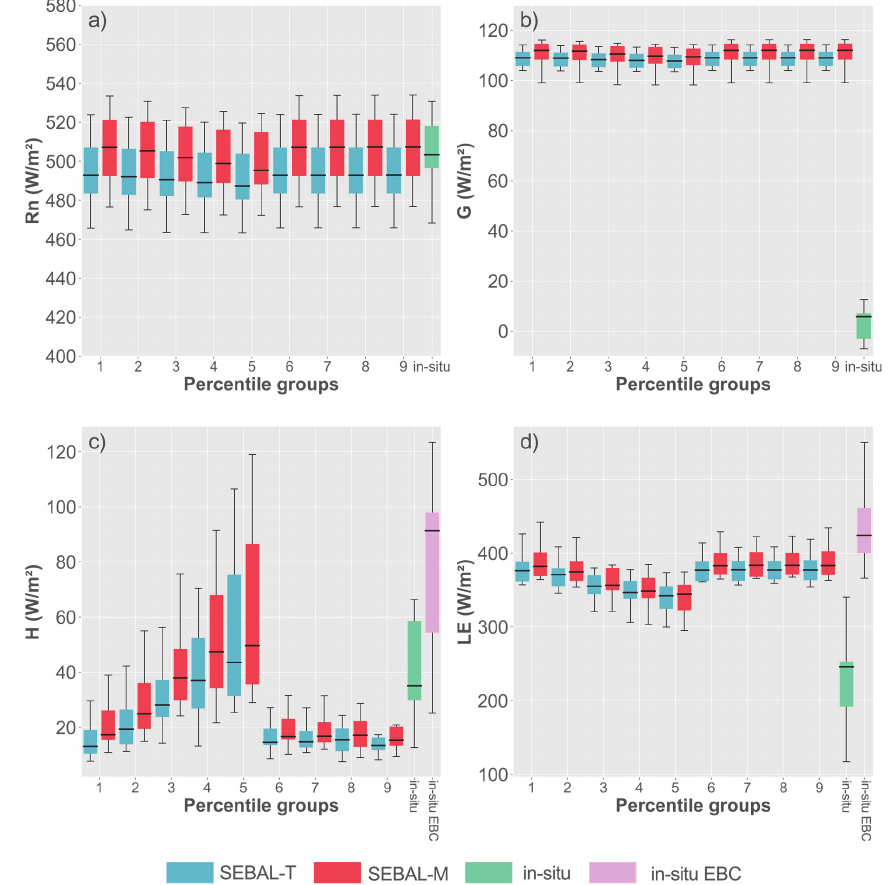
Figure 4. Comparisons of instantaneous surface energy fluxes (net radiation ( R n ) ( a ), soil heat ( G ) ( b ), sensible heat ( H ) ( c ), and latent heat ( LE ) ( d )) between ground measurements (where in situ stands for measurements without energy balance closure and in situ EBC for measurements with energy balance closure) and SEBAL estimations driven by meteorological measurements (SEBAL-T) and MERRA-2 (SEBAL-M) for nine quantile groups of endmember selection at the JAV site. With an increase in H estimations (for both meteorological inputs) for quantiles g A − g Ts 4 , LE estimations decreased for the same quantiles and held steady for quantiles g IV 1 − g IV 4 . Overall, without energy balance closure, instantaneous LE was overestimated, with MAE (RMSE) ranging − 2 between 111.6 (128.1) and 156.3 (169.9) W m for SEBAL-T and between 95.8 (98.7) and 149.3 − 2 (152.0) W m for SEBAL-M. When correcting instantaneous measurements of LE according to the energy balance closure, LE increased accuracy, with an underestimation, with MAE (RMSE) ranging − 2 − 2 between 52.3 (66.0) and 97.1 (113.1) W m for SEBAL-T and between 89.5 (93.9) and 143.0 (144.5) W m for SEBAL-M. As a residual of the energy balance, instantaneous estimates of LE for quantiles g A and g IV 1 − g IV 4 yielded the most accurate estimates. MAE and RMSE of all estimated quantiles for Rn , G , H , and LE are presented in Tables S1 and